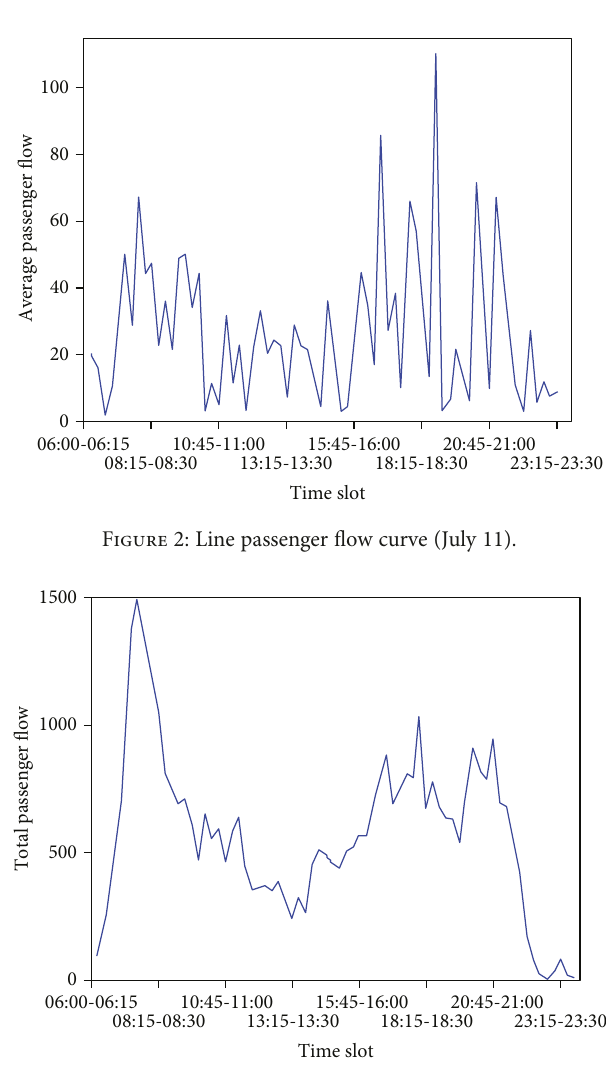
Figure 3: Line overall passenger fl ow curve (July 1 – 15).